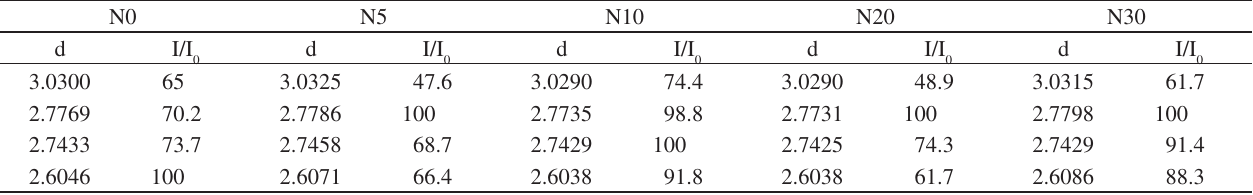
S/C S main peaks in different samples (d),and their corresponding relative intensities (I/I 3 2